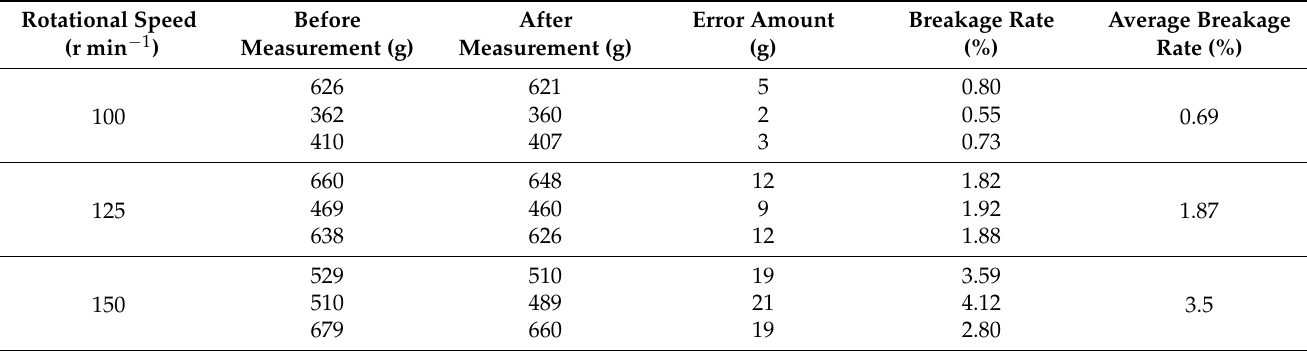
Table 9. Results of the breakage rate at various rotational speeds.